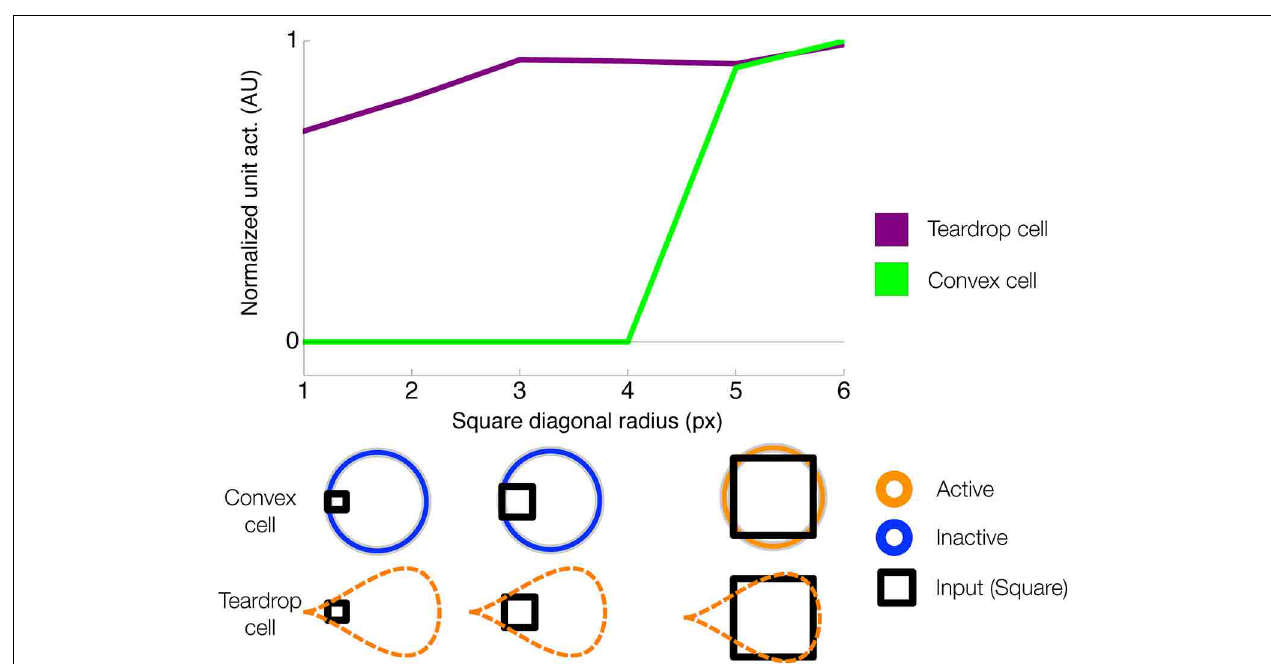
FIGURE A1 | Teardrop cells demonstrate the size invariance property. The size of the square is labeled “1” to “6,” from smallest to largest, respectively. The activity of a convex cell (orange) and a teardrop cell (blue) is plotted when the six squares of different sizes were presented within the